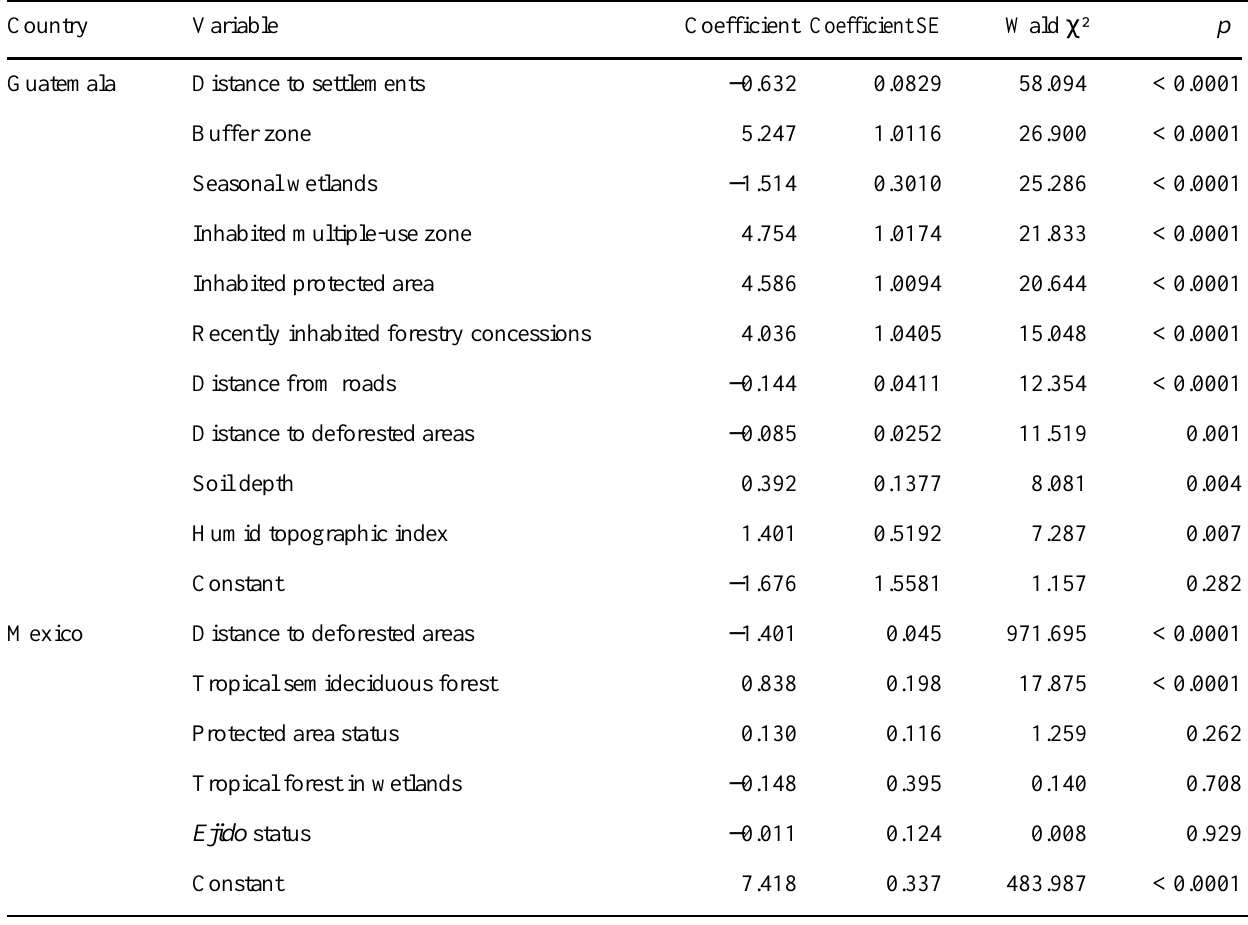
Table 2. Outputs of logistic regression analyses for Guatemala and Mexico showing the influence of the spatially independent variables used to explain deforestation